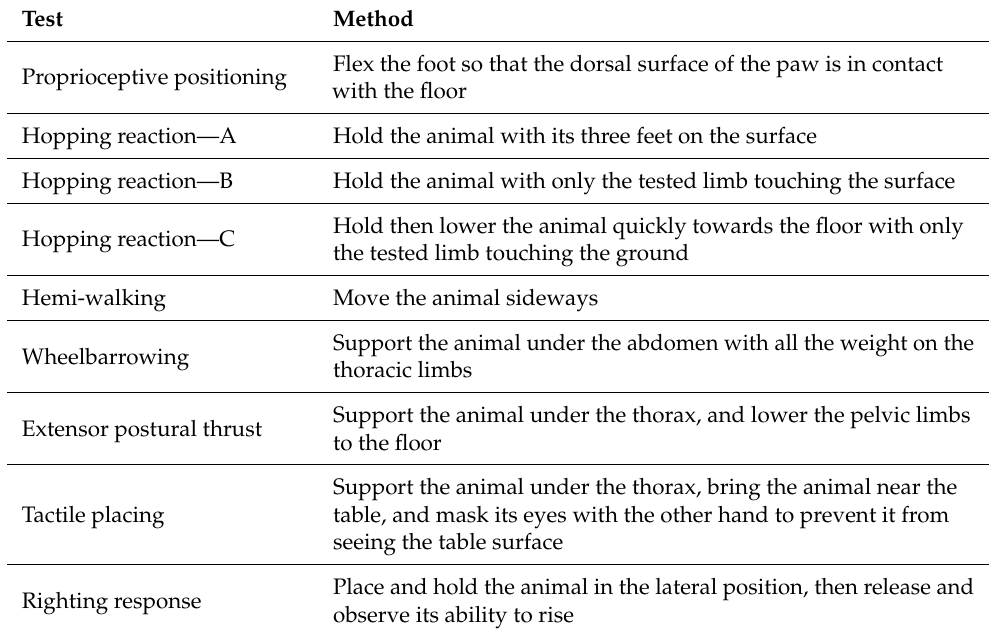
Table 1. Methods for individual postural reaction